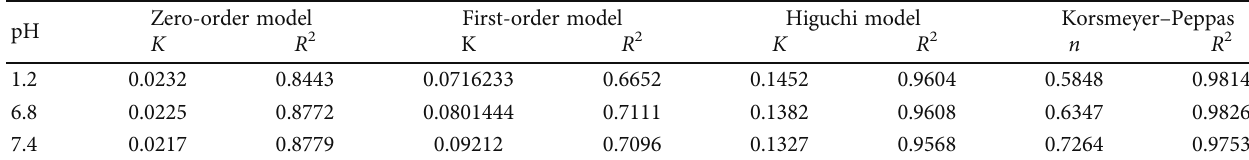
Table 3: Drug release kinetics for MTZ from hydrogel